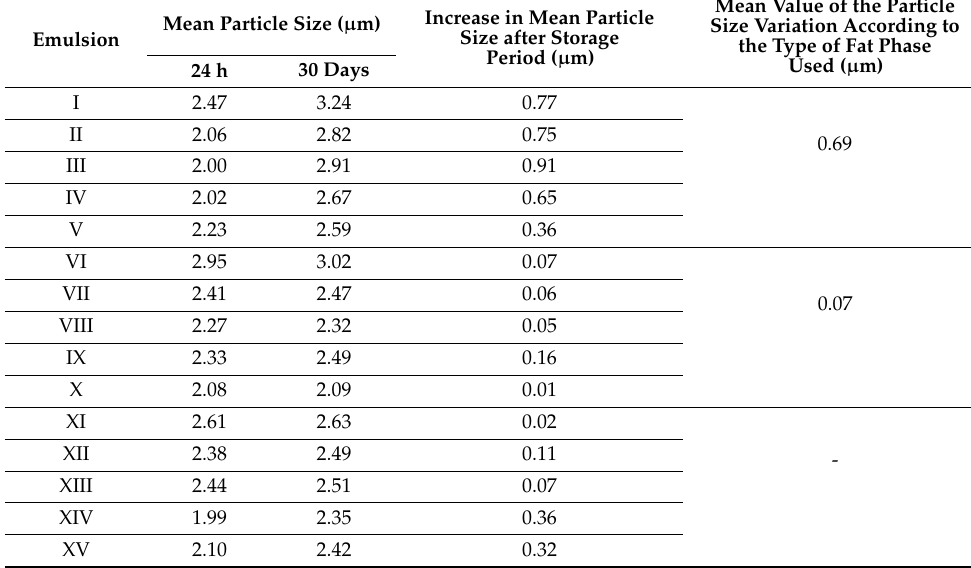
Table 1. Particle size of